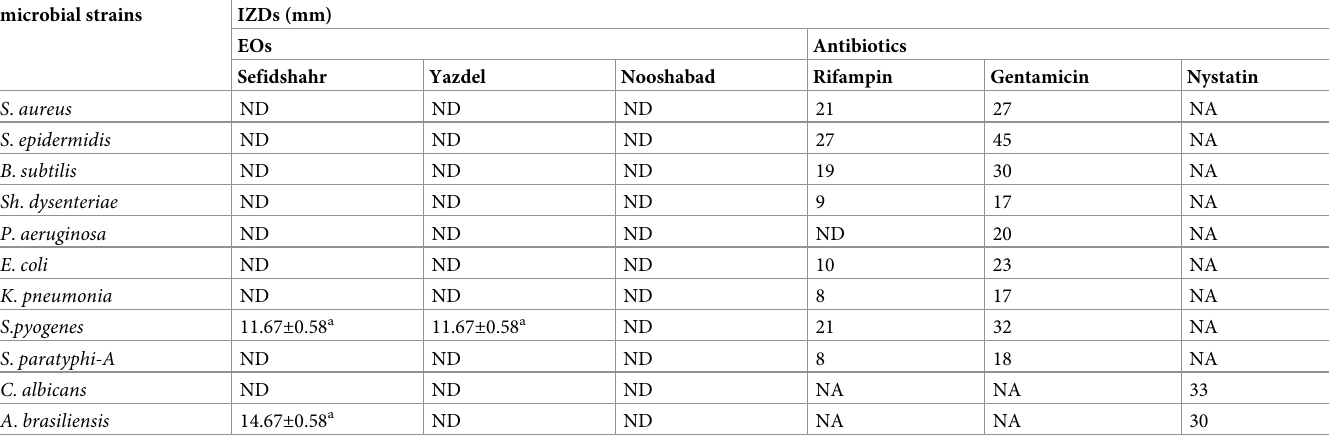
Results are expressed as means ± SD of triplicate values. ND: not determined. NA: no activity. Values with different letters are statistically different (Duncan, p �